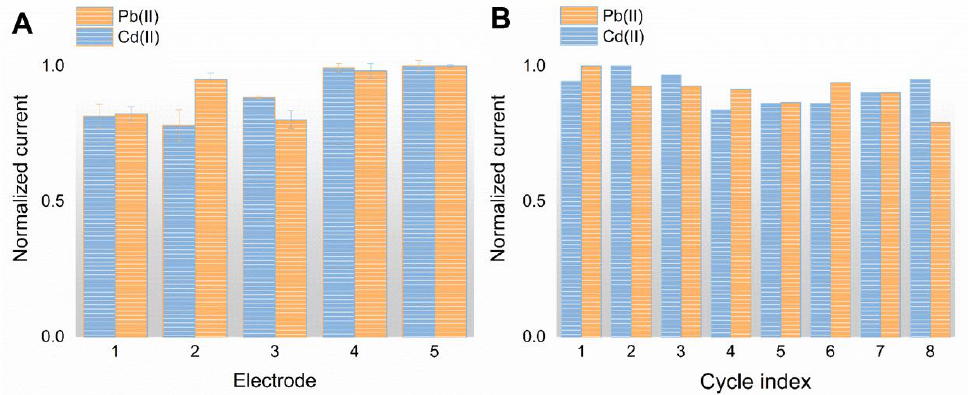
Figure 5. Reproducibility and stability testing results of the SPE/NPC. ( A ) Stripping responses of five